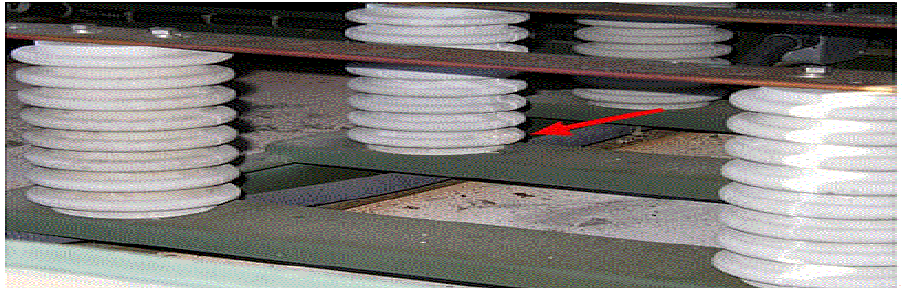
Figure 14. Dust on a bushing supports the arcing condition [36] .